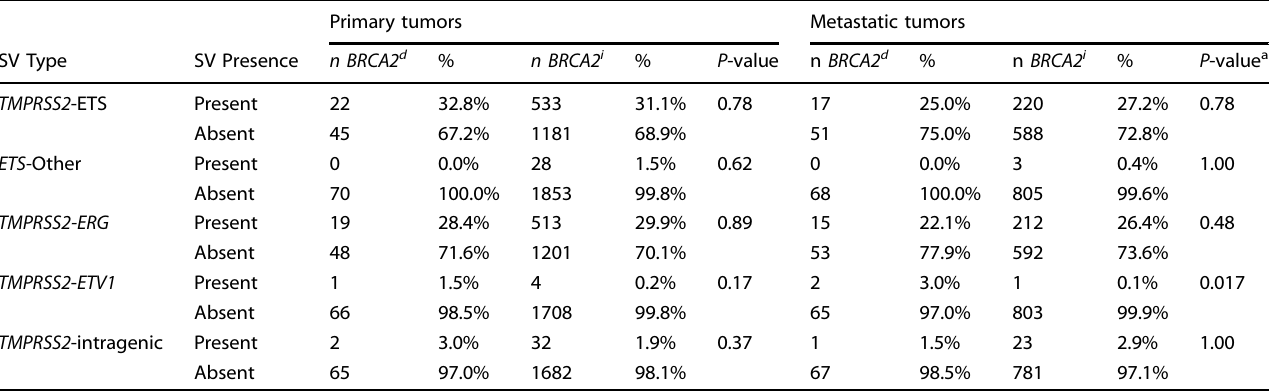
Table 1. Structural variant (SV) frequency by tumor BRCA2 alteration status for primary and metastatic prostate tumors in GENIE and TCGA. Primary tumors Metastatic